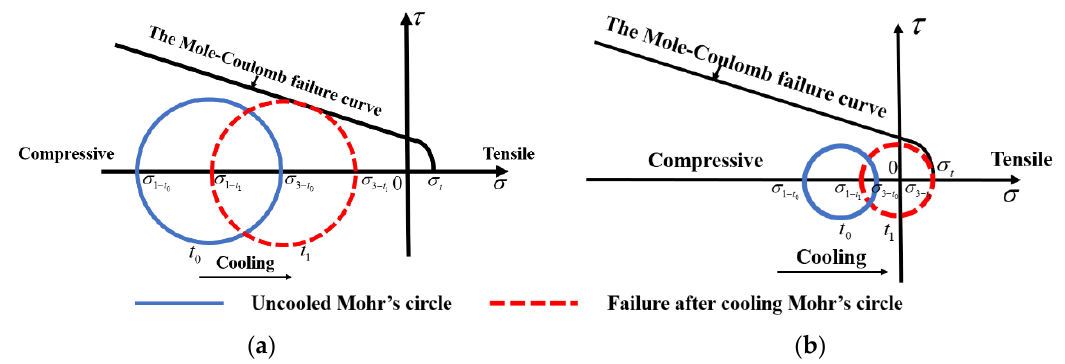
Figure 2. ( a ) Shear failure under large deviating stress after cooling. ( b ) Tensile failure under small deviational stress after cooling. 𝑡 0 : the moment when high-temperature rock starts to cool; 𝑡 1 : the first moment when high-temperature rock fails after cooling; 𝜎 𝑡 : rock tensile strength; 𝜎 1 − 𝑡 0 : the first principal stress at t = 𝑡 0 ; 𝜎 1 − 𝑡 1 : the first principal stress at t = 𝑡 1 ; 𝜎 3 − 𝑡 0 : the third principal stress at t = 𝑡 0 ; and 𝜎 3 − 𝑡 1 : the third principal stress at t = t 1 .